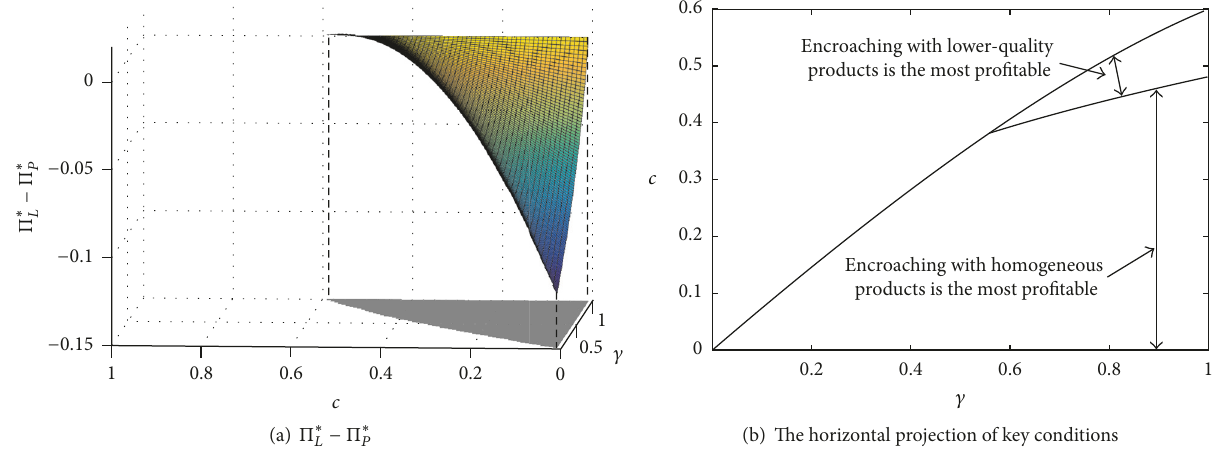
Figure 4: Key conditions of the three